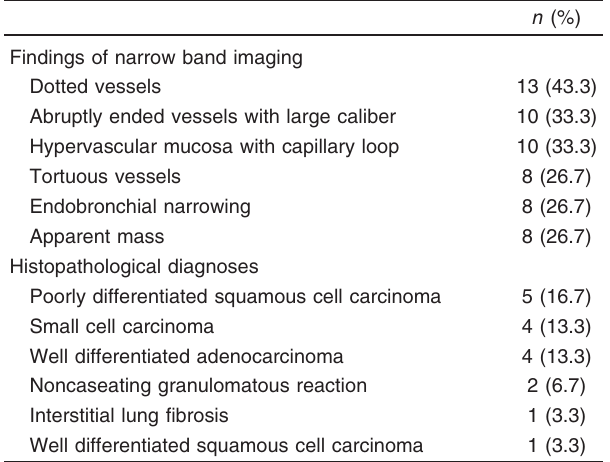
Table 5 Comparison between white-light bronchoscope and narrow band imaging n (%) WLB